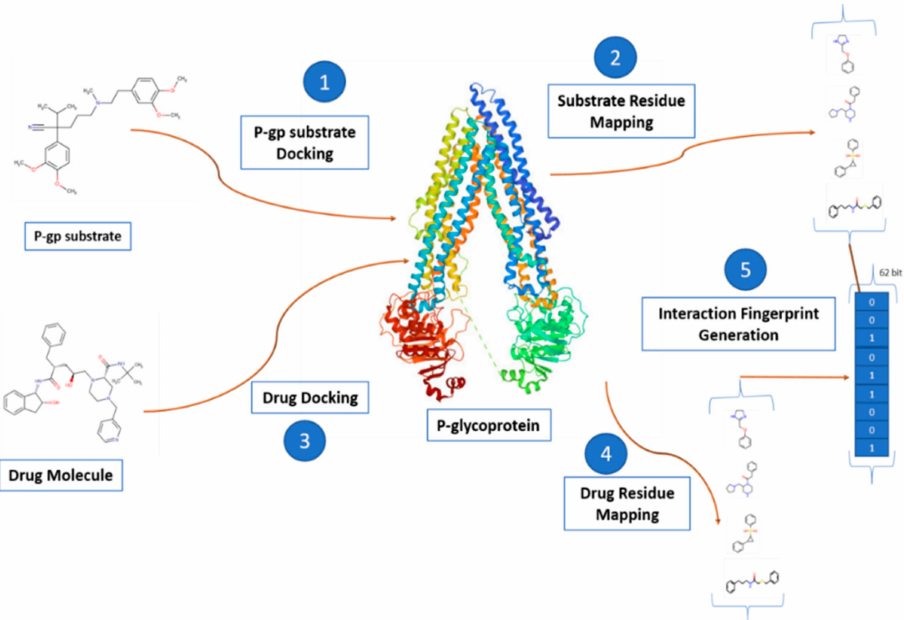
Figure 2. Residue-based pharmacophore fingerprint: DockedFP(1a). (1) The P-gp substrate is docked with the receptor. (2) The active site residue interacting with the P-gp substrates is mapped. (3) The drug is docked with the P-gp receptor. (4) The residues of the active site binding to the drug are mapped. (5) A custom python loop to generate an interaction fingerprint using both the P-gp substrate and drug mappings.